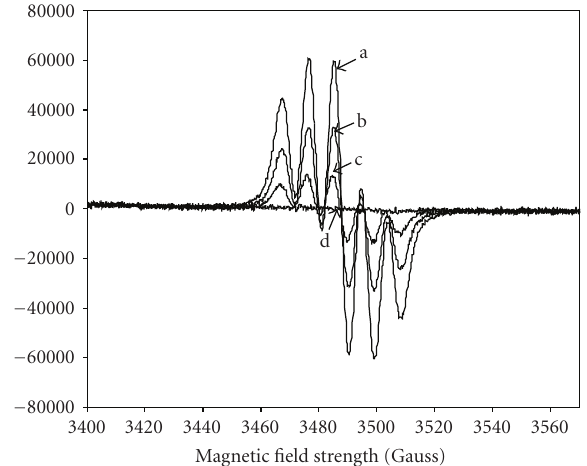
Figure 4: EPR spectra of DPPH /Rottlerin solutions in absolute ethanol. (a) 20 μ M DPPH ethanol solution (A); (b), (c), and (d) correspond to the (b), (c), and (d) solutions of Figure 2. All spectra were recorded in the same experimental